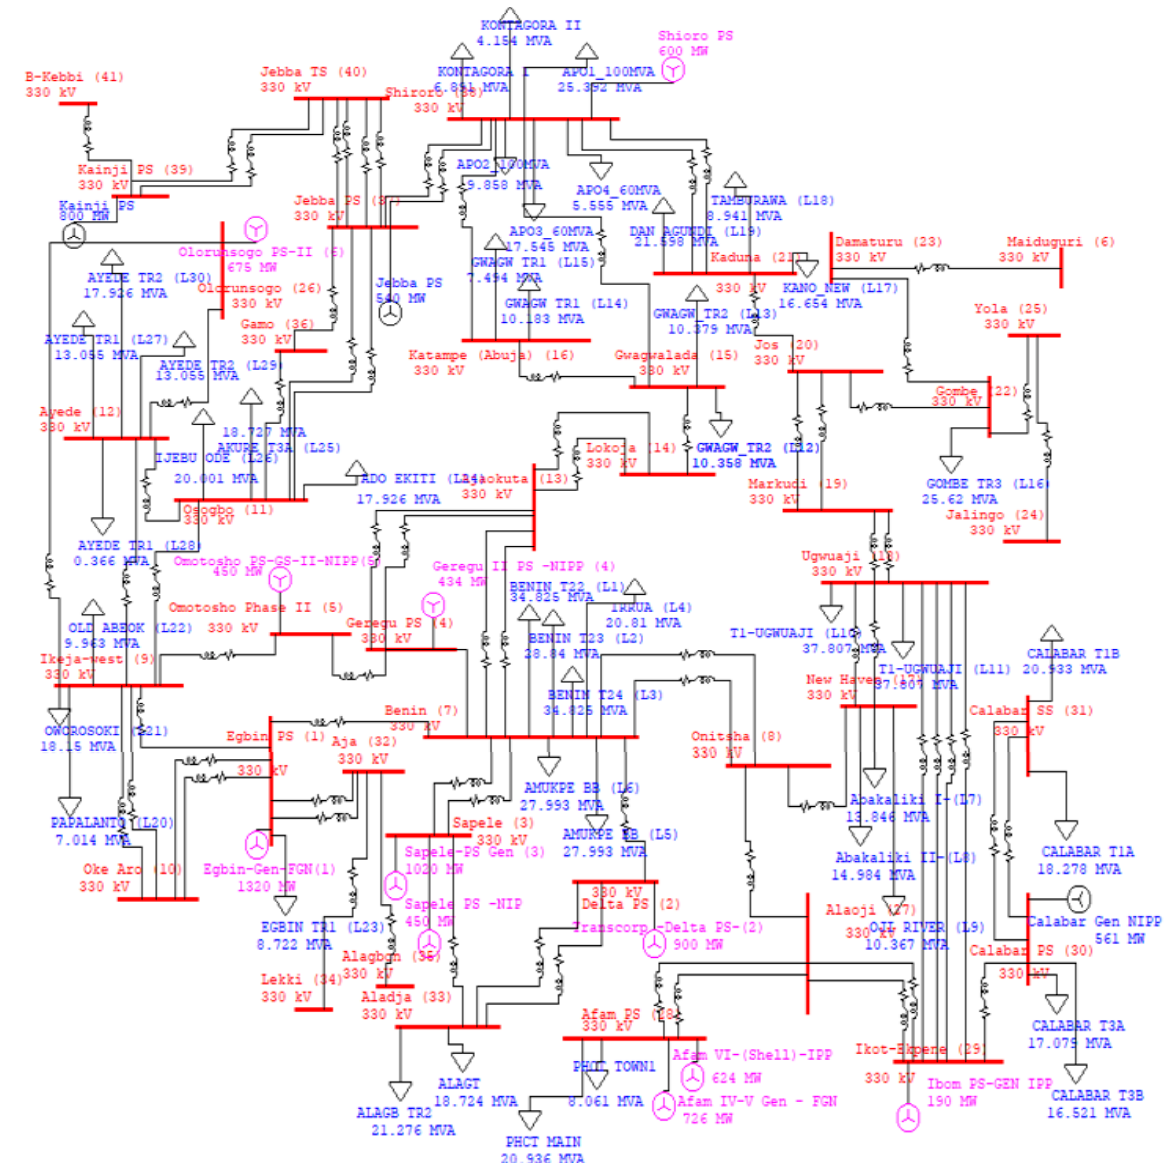
Figure 3. Line diagram of Nigerian 41 bus transmission network [35]. Table 1. Nigerian transmission network component.